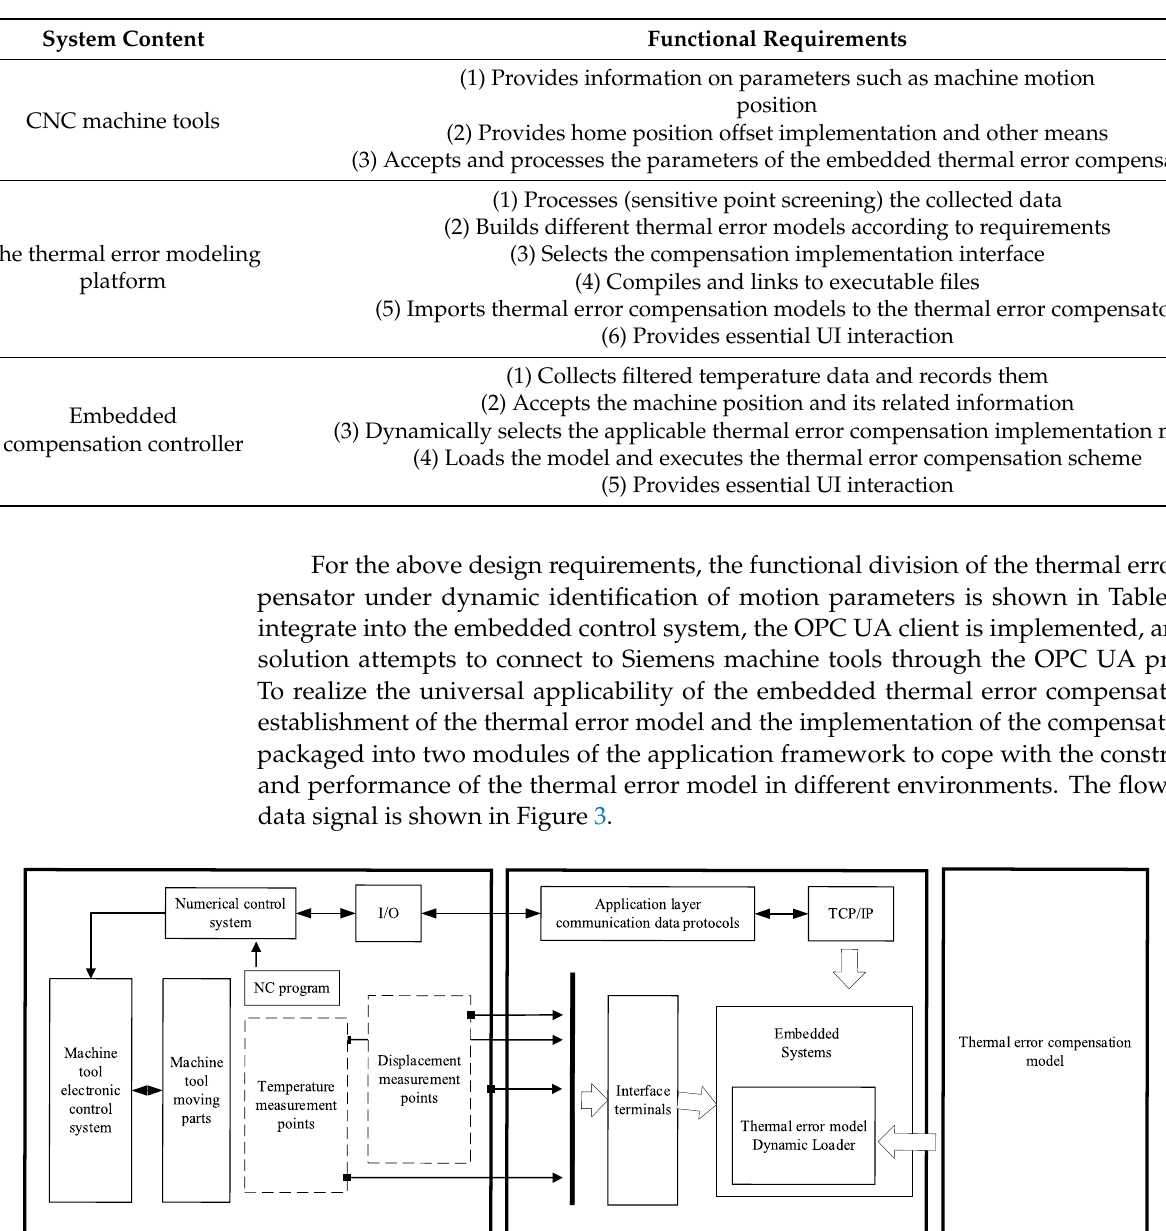
Table 1. System functional requirements for dynamic motion parameter recognition.